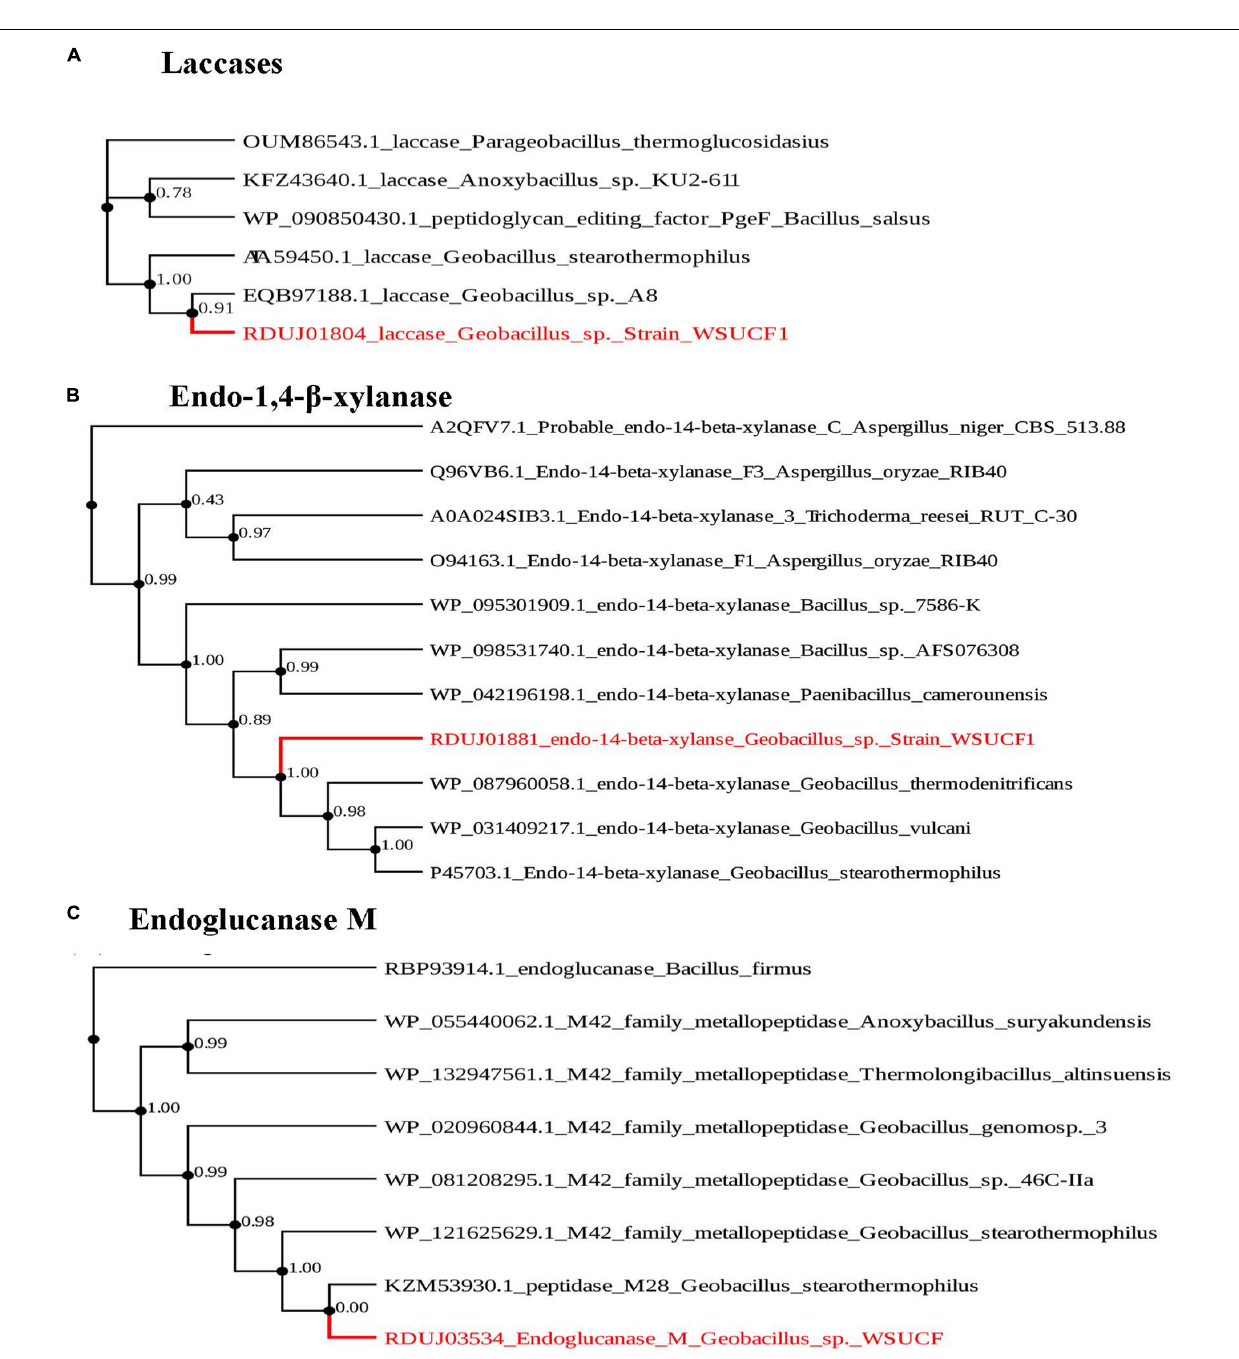
FIGURE 2 | Phylogenetic tree of key enzymes found in Geobacillus sp. strain WSUCF1. Here, (A) phylogenetic tree of laccase from Geobacillus sp. strain WSUCF1 and other laccases from Parageobacillus thermoglucosidasius , Anoxybacillus sp. KU2-611 , Bacillussalsus , Geobacillus stearothermophilus , and Geobacillus stearothermophilus. Laccase from Geobacillus sp. strain WSUCF1 was identified with HAMMER. (B) Phylogenetic tree of endo-1,4- β -xylanase from G eobacillus sp. strain WSUCF1 and other endo-1,4- β -xylanases from fungi Trichoderma reesi RUT C-30, Aspergillus oryzae RIB40, Aspergillus Niger CBS 513.88 and bacteria Paenibacillus camerounensis, Bacillus sp. AFS0763308, Geobacillus vulcani, Geobacillus stearothermophilus , Geobacillus thermodenitrificans , and Bacillus sp. 7586-k. (C) Phylogenetic tree of Endoglucanase M from G eobacillus sp. strain WSUCF1 and one endoglucanase from Bacillus firmus and peptidases from Anoxybacillus suryakundensis , Thermologi Bacillus altinsuensis , Geobacillus genome sp. 3 , Geobacillus sp. 46C-IIa , and Geobacillus stearothermophilus . The nearest neighbor interchange was used for tree searching, and aBayes was used for branch support. PhyML was used to create the tree which uses Maximum likelihood methods. The substitution model used was Bayesian information criterion (BIC), nearest neighbor interchange was used for tree searching, and aBayes was used for branch support.